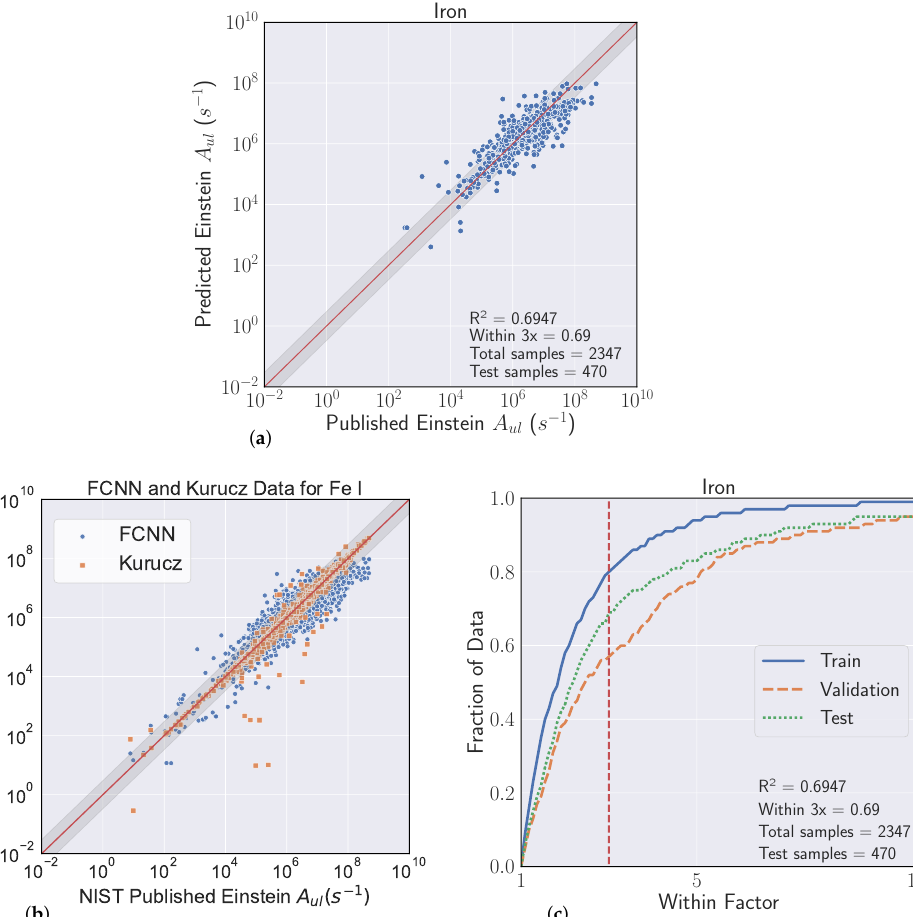
Figure 3. Performance metrics for iron neural network predictions. ( a ) comparison of predicted vs. published NIST transition probability test set; ( b ) comparison with Kurucz atomic data for Fe I electric dipole transitions showing spread between FCNN predictions and the Kurucz data relative to the published NIST values; ( c ) fraction of predicted values within a factor of the published transition probability value for the training, validation, and test